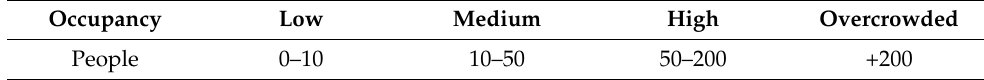
Table 1. Occupancy in an academic environment.